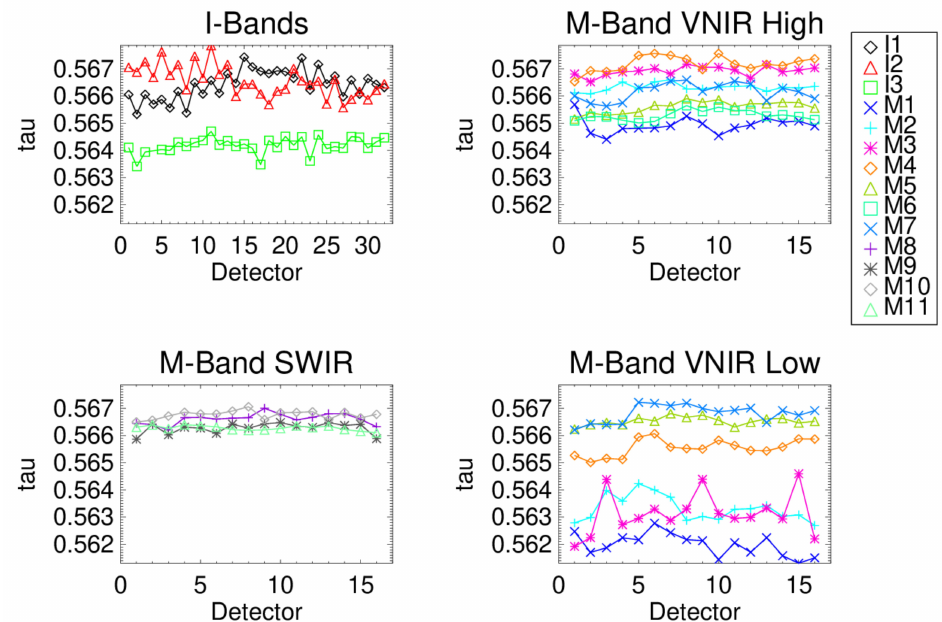
Figure 11. Comparison of the tau coefficient for all RSBs at nominal TVAC plateau. The upper left are the I-bands, upper right high gain VNIR M-bands, lower left the SWIR M-bands, and the lower right the low gain VNIR M-bands. The x-axis is detector, and the colors/symbols correspond to a particular RSB.